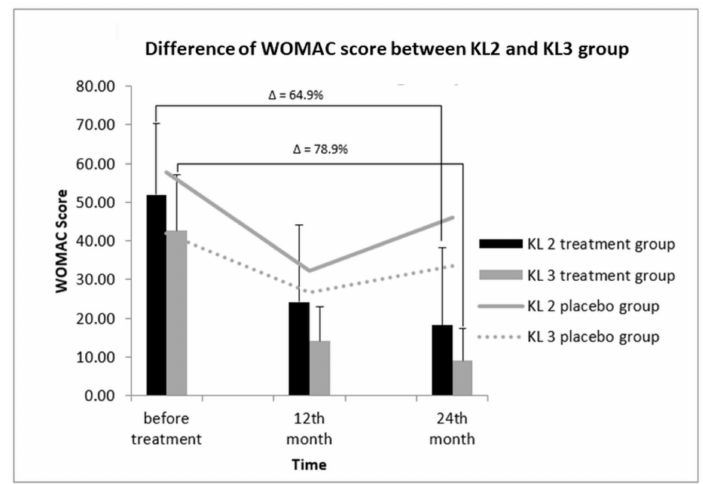
Figure 5. WOMAC scores in KL-grade 2 and 3 patients after SVF therapy at 12 and 24 months. After treatment, the reduction of the WOMAC score in KL-grade 3 patients was comparatively greater than that observed in KL-grade 2 patients (78.9% vs. 68.9%). The WOMAC scores of KL-grade 2 and 3 patients in the placebo group remained constant. ∆ : percentage of reduction in WOMAC